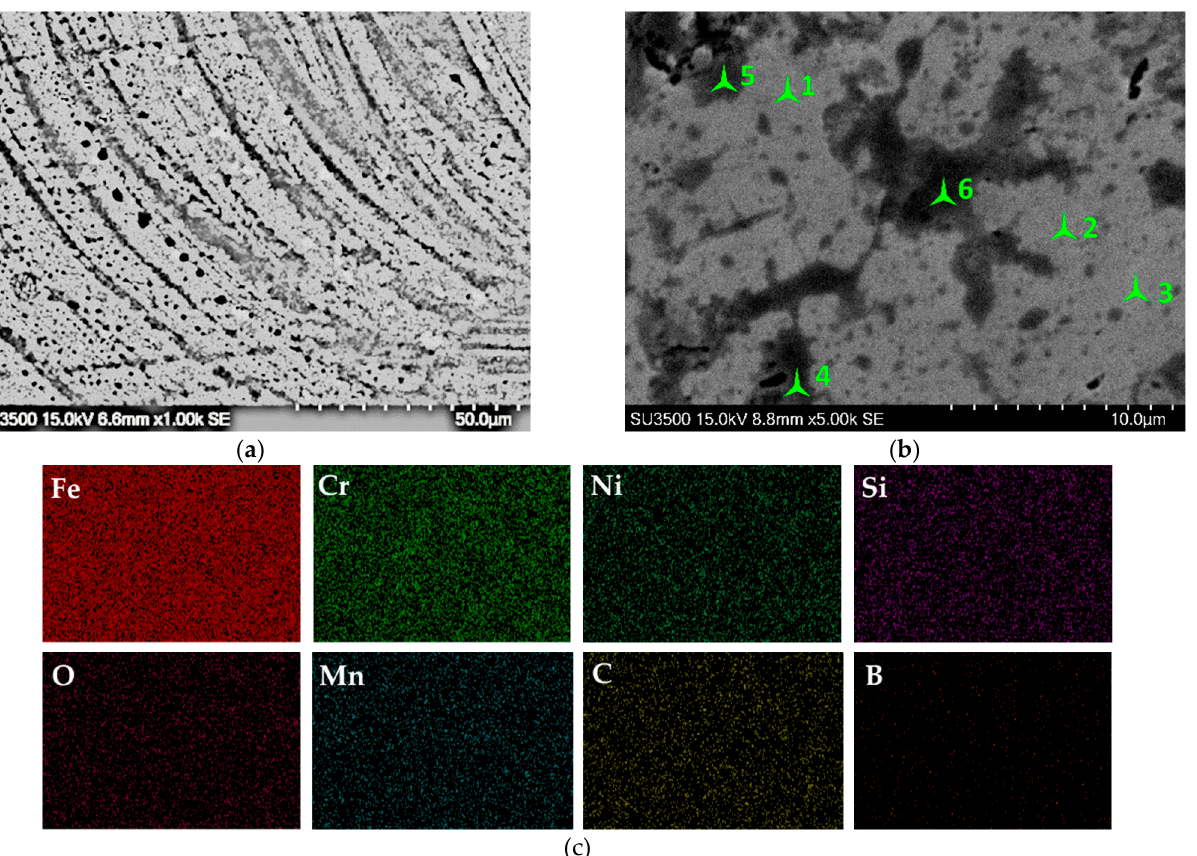
Figure 12. The scanned spectra positions ( a ); mapped general friction surface ( b ); and EDS mapping ( c ) of the general friction surface tested at 4 MPa. Table 5. The composition of the spectra. Element